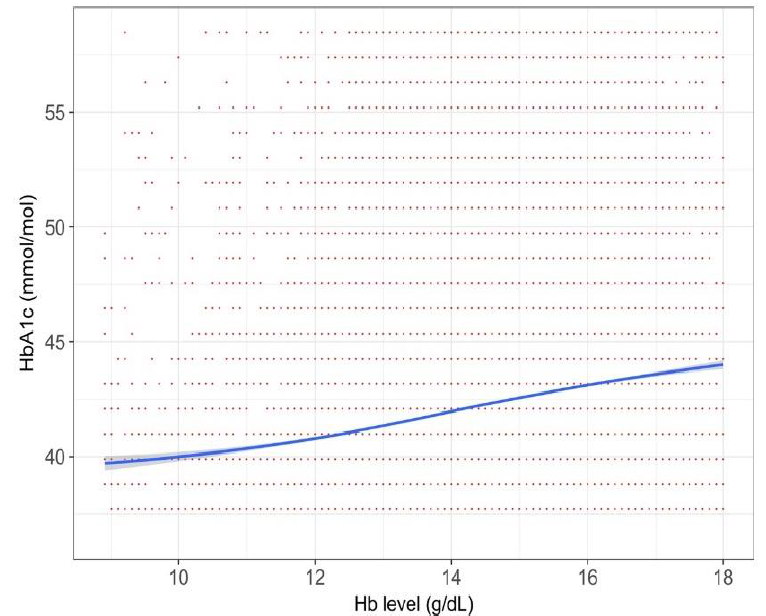
Figure 3. The relationship between Hb and HbA 1c value in persons with HbA 1c values of around 48 mmol/mol ( n = 18,478). Graph was created with a 75% random sampling. (6253 persons), we found a global right upper tend (Figure 4).